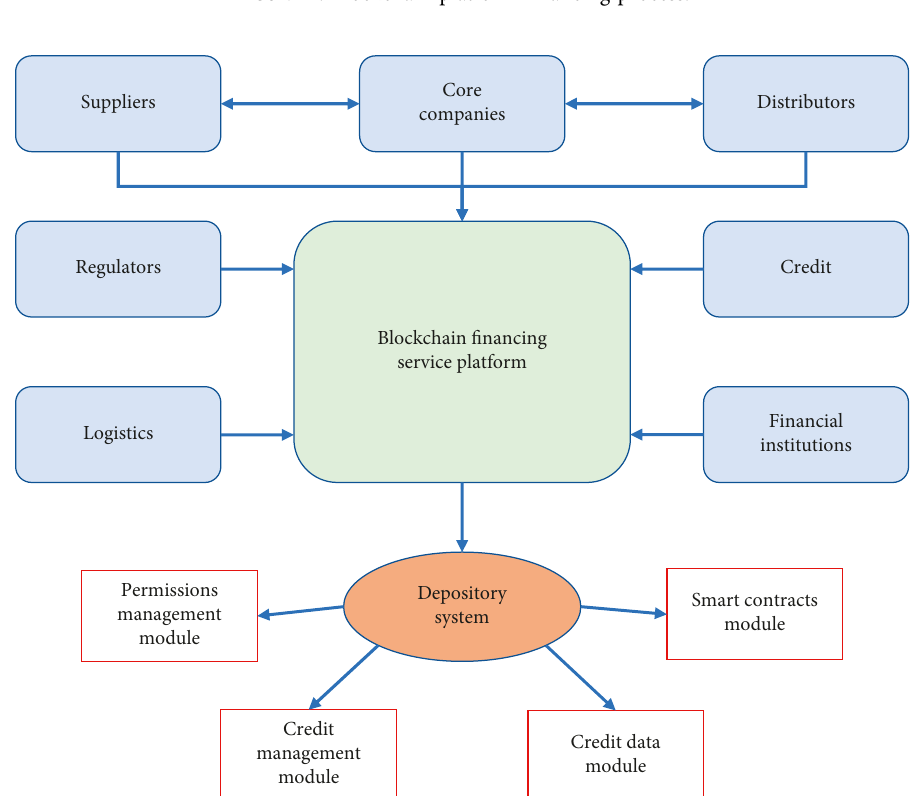
Figure 2: Blockchain financing service platform.